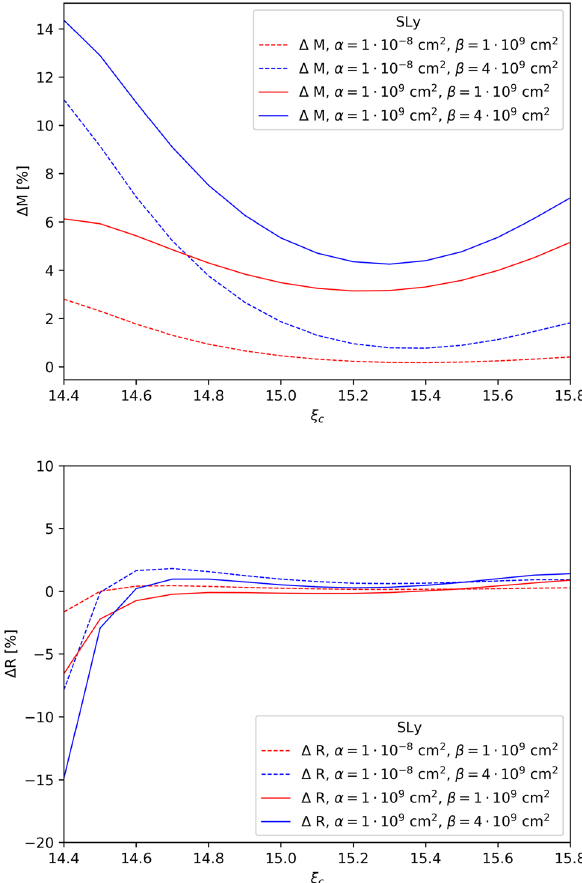
Fig. 14 Difference between the mass (upper panel) and the radius (lower panel) obtained, given a central density value ξ , with f ( R , Q ) = R + α R 2 + β Q and GR, for the SLy